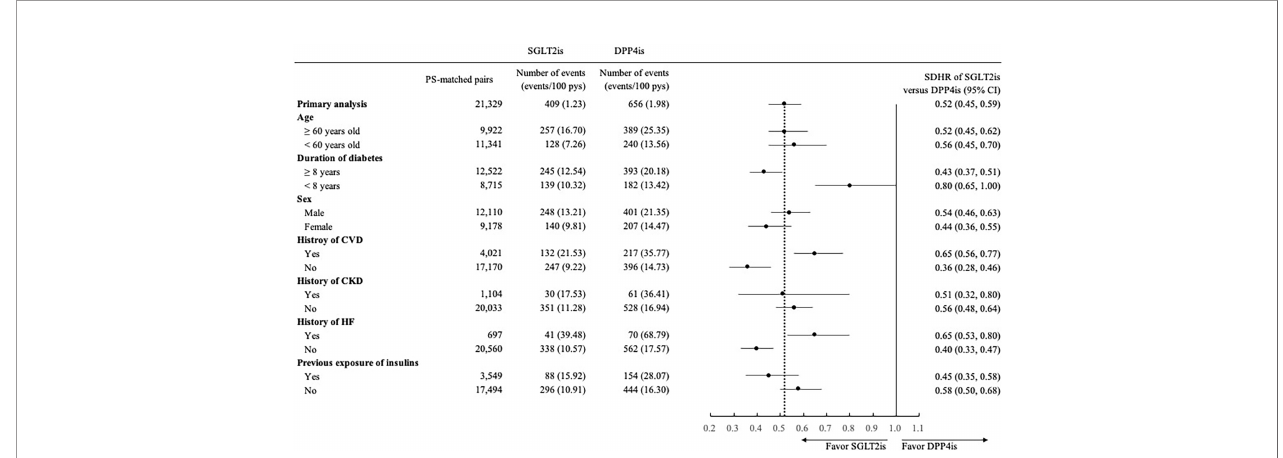
FIGURE 1 | Forest plot of subgroup analyses for hospitalization for heart failure associated with use of SGLT2is versus DPP4is. SGLT2is, sodium glucose cotransporter-2 inhibitors; DPP4is, dipeptidyl peptidase-4 inhibitors; PS, propensity score; pys, person-years; SDHR, subdistribution hazard ratio; CI, con fi dence interval; CVD, cardiovascular disease; CKD, chronic kidney disease; HF, heart failure.